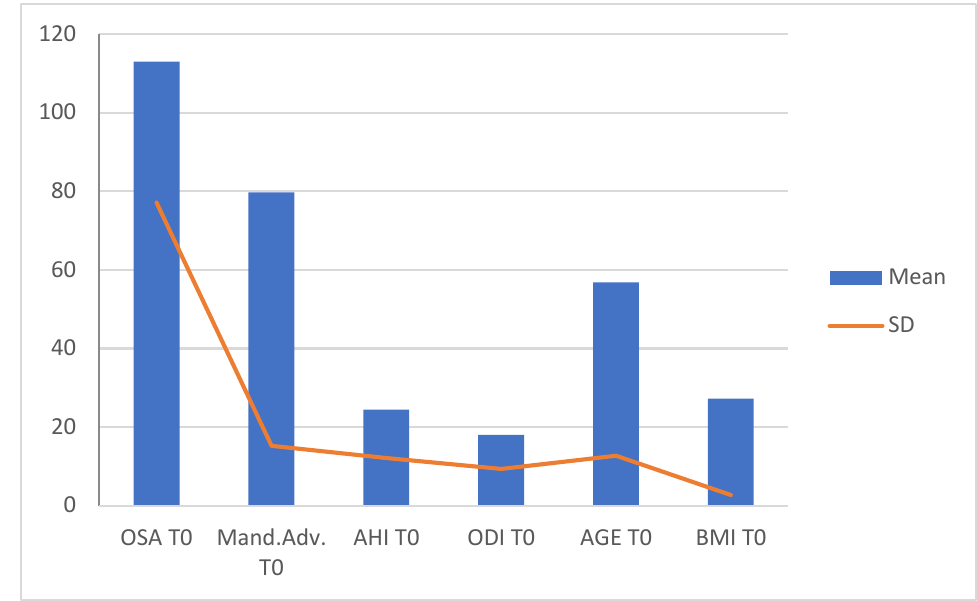
Figure 3. Descriptive variables table in patients who neither developed nor increased the number of CSA.